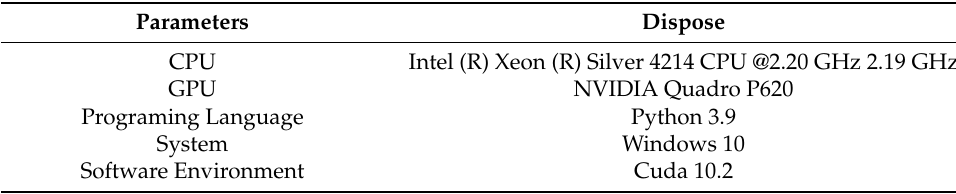
Table 1. Configuration parameters of experimental platform.